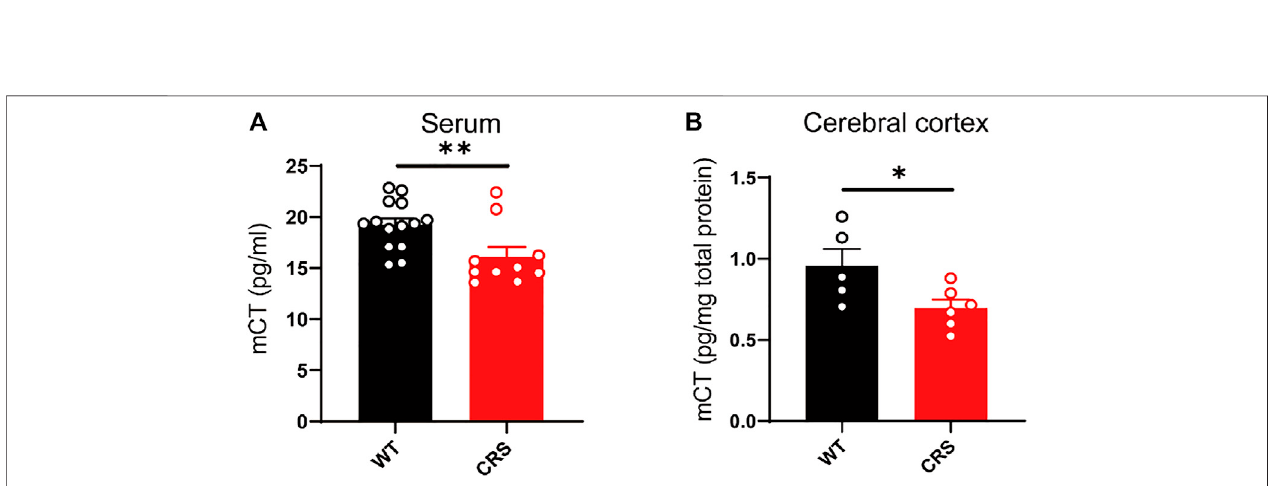
FIGURE3| The level ofmCTwasreduced inthe serum and cerebral cortex ofCRSmice.mCT wasreduced in theserum ofCRSmodel (WT: n =14; CRS: n =10) (A) . mCT was reduced in the cerebral cortex of CRS model (WT: n = 5; CRS: n = 6) (B) . The data were analyzed by unpaired t -test. *p < 0.05, **p < 0.01. CRS, chronic restraint stress; WT, wild